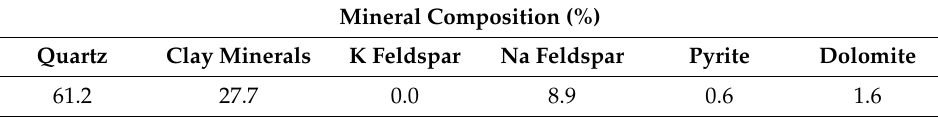
Figure 1. The geographical location of the Bazhenov Formation. Table 1. Rock-forming minerals of the target formation.